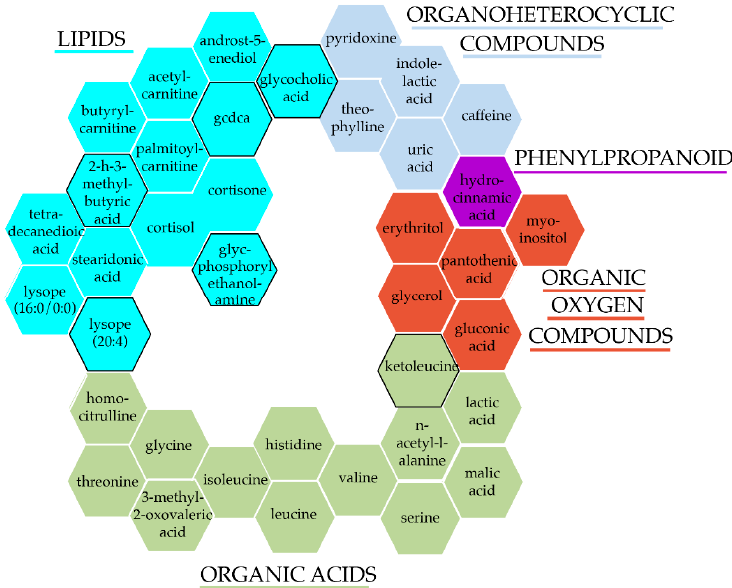
Figure 1. Hypertension-associated metabolites after adjusting for traditional risk factors. Colours and groupings represent each metabolite super class, while a black border signifies novel-associations with hypertension/BP.